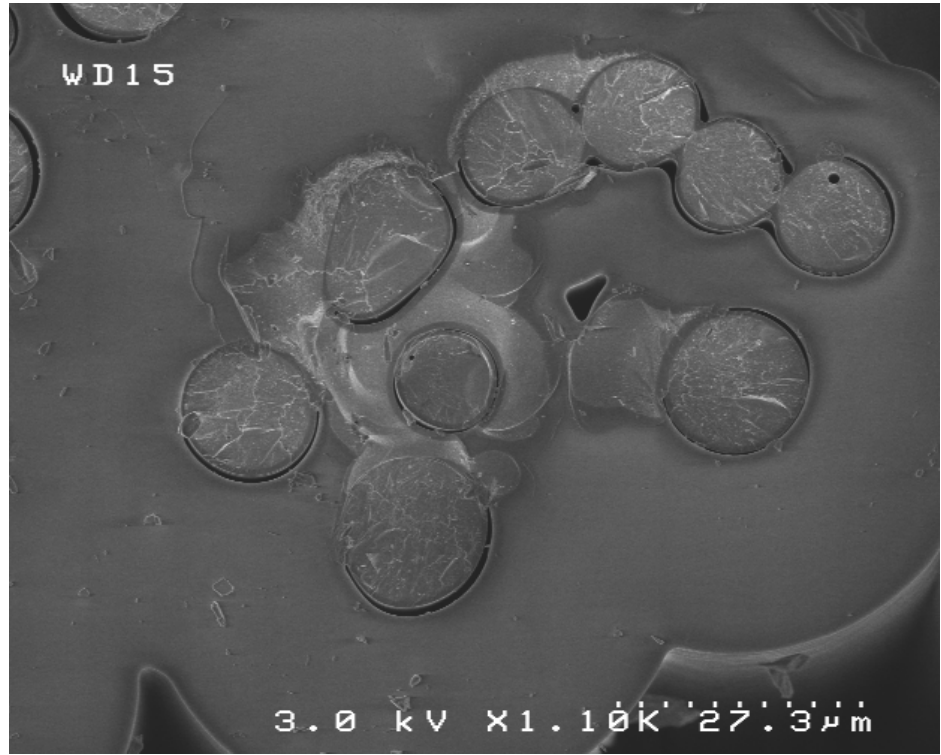
Figure 13. Filaments bonded together, or bonded to the matrix by oxide in a minicomposite tested at 1200 °C.